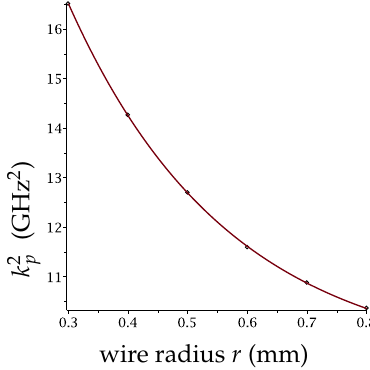
L x and 1 L y . This is 4 4